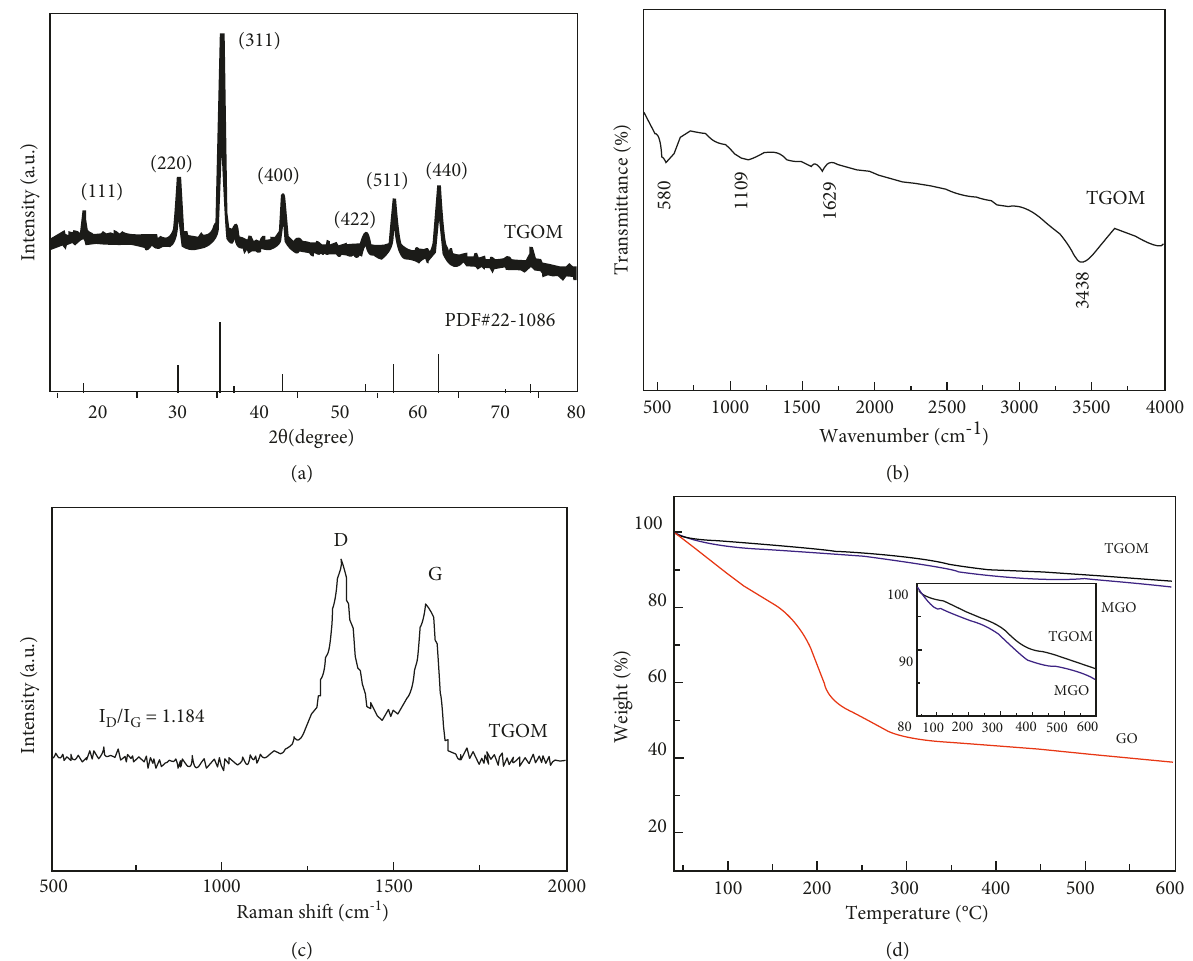
Figure 2: (a) XRD pattern of TGOM; (b) FT-IR spectrum of TGOM; (c) Raman spectrum of TGOM; (d) TGA thermogram of GO, MGO, and